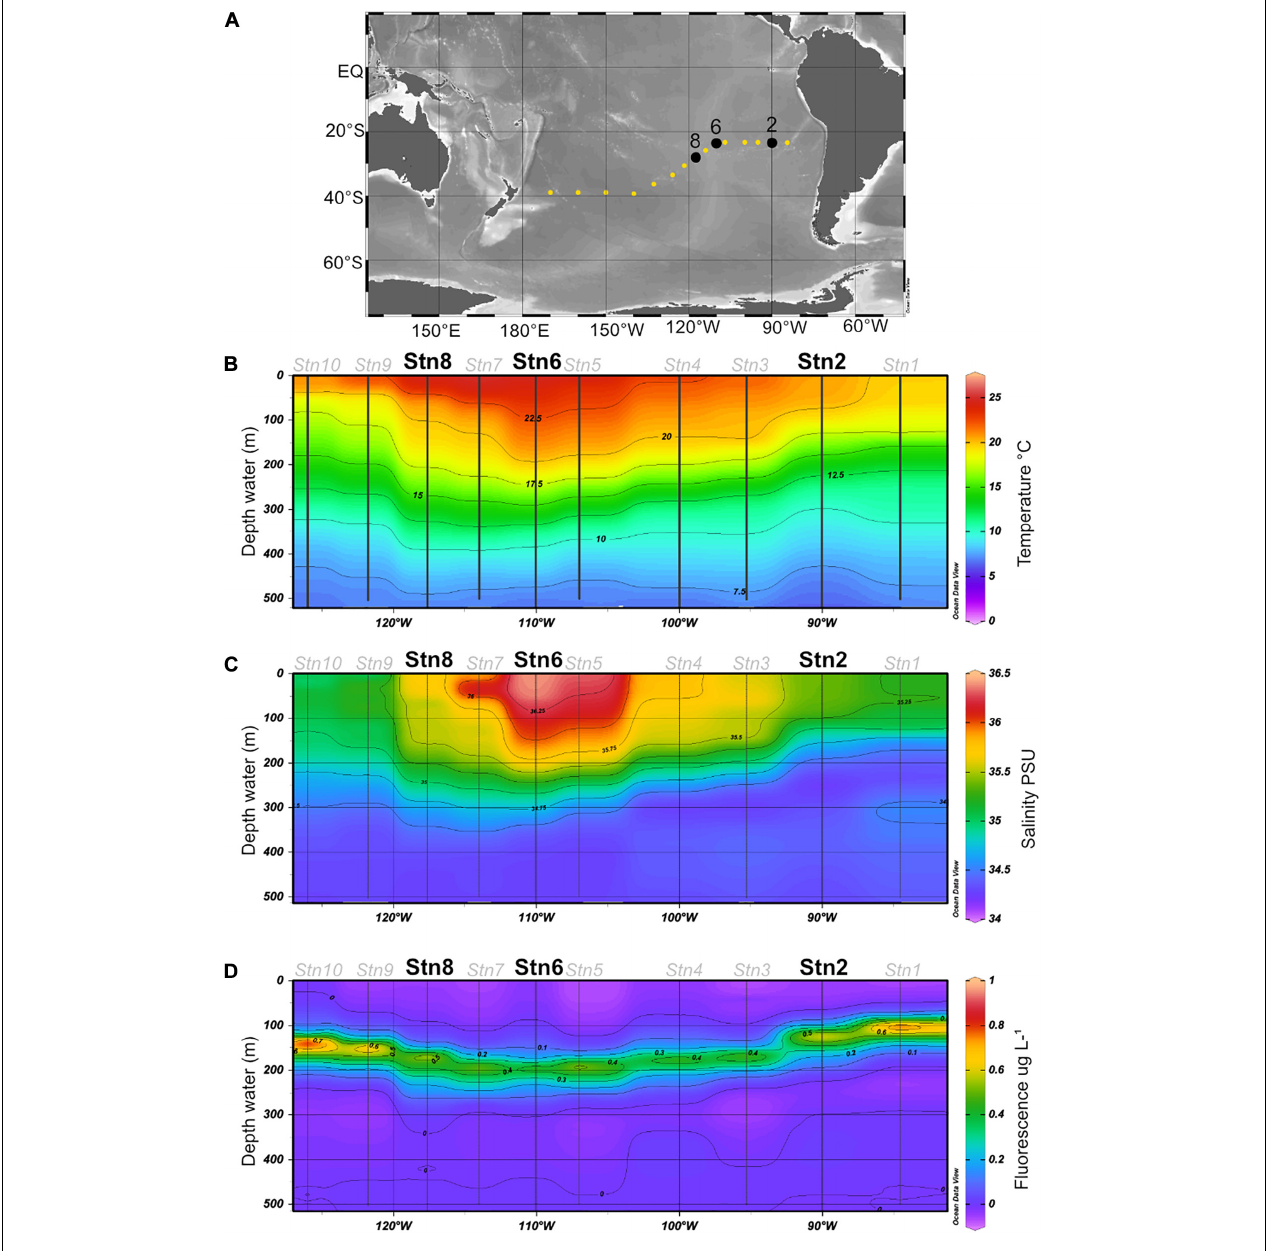
FIGURE 1 | (A) Cruise track for the SO245 expedition; Stns 2, 6, and 8 are shown in black. (B–D) Temperature, salinity, and fluorescence in the upper 500 m of the water column, plotted from CTD data (see section “Materials and Methods”) obtained at Stns. 1–10. All figures were created using Ocean Data View software (Schlitzer,